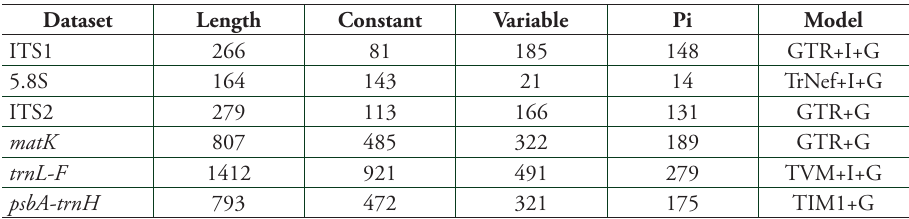
Table 1. Sequence characteristics with gaps as missing data: alignment length, the number of the con- stant, variable and potential parsimony-informative (Pi) sites, and the best-fit nucleotide substitution model determined by